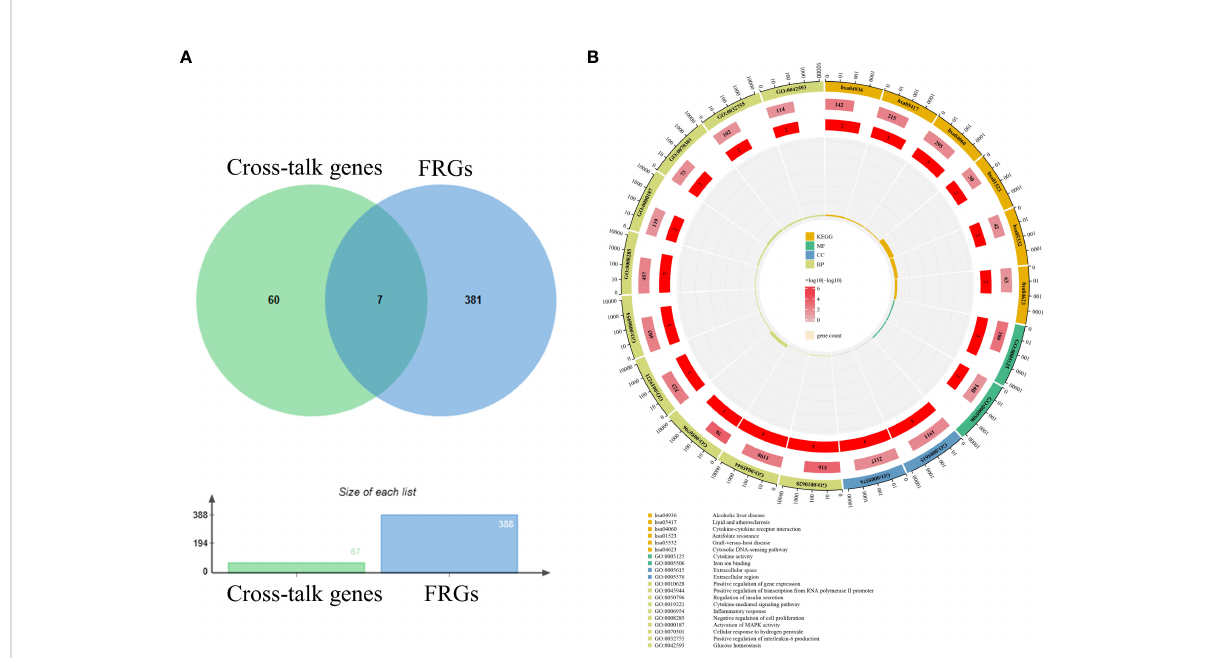
FIGURE 5 Venn diagram and enrichment analysis of FR-cross-talk genes. (A) Seven FR-cross-talk genes were identi fi ed by venn diagram. (B) The GO and KEGG enrichment analysis of FR-cross-talk genes.